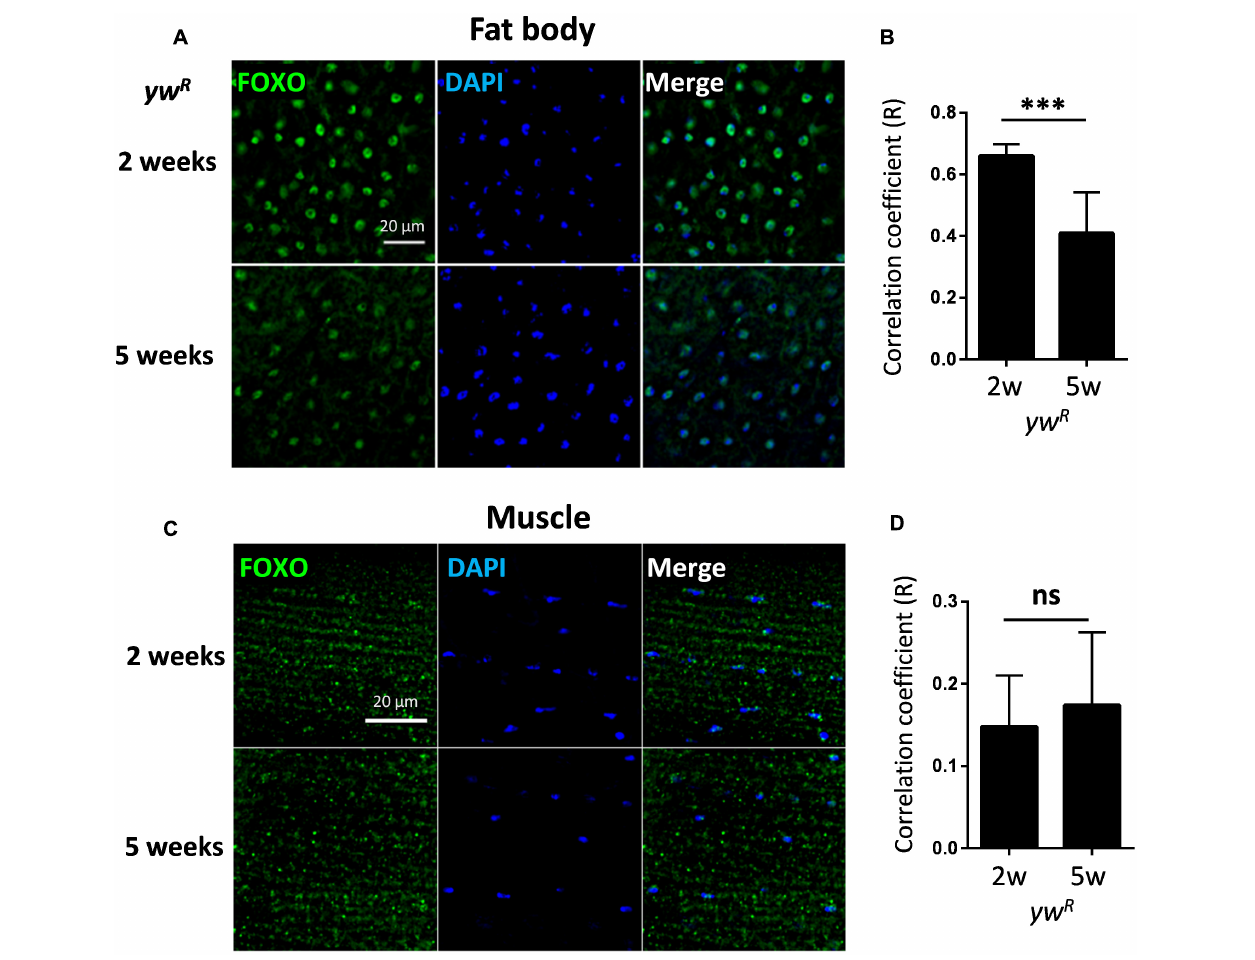
FIGURE 1 | FOXO exhibits constitutive nuclear localization in both young and aged adult tissues. (A) Abdominal fat body of wild-type female flies ( yw R ) stained with anti-FOXO at ages of 2 and 5 weeks. (B) Quantification of Pearson correlation coefficient (R) between FOXO and DAPI staining in fat body tissue. (C) FOXO immunostaining in young and aged indirect flight muscles of wild-type female flies ( yw R ). (D) Quantification of Pearson correlation coefficient ( R ) between FOXO and DAPI in indirect flight muscles. Scale bar: 20 µ m. Student t -test ( ∗∗∗ p < 0.001; ns, not significant).